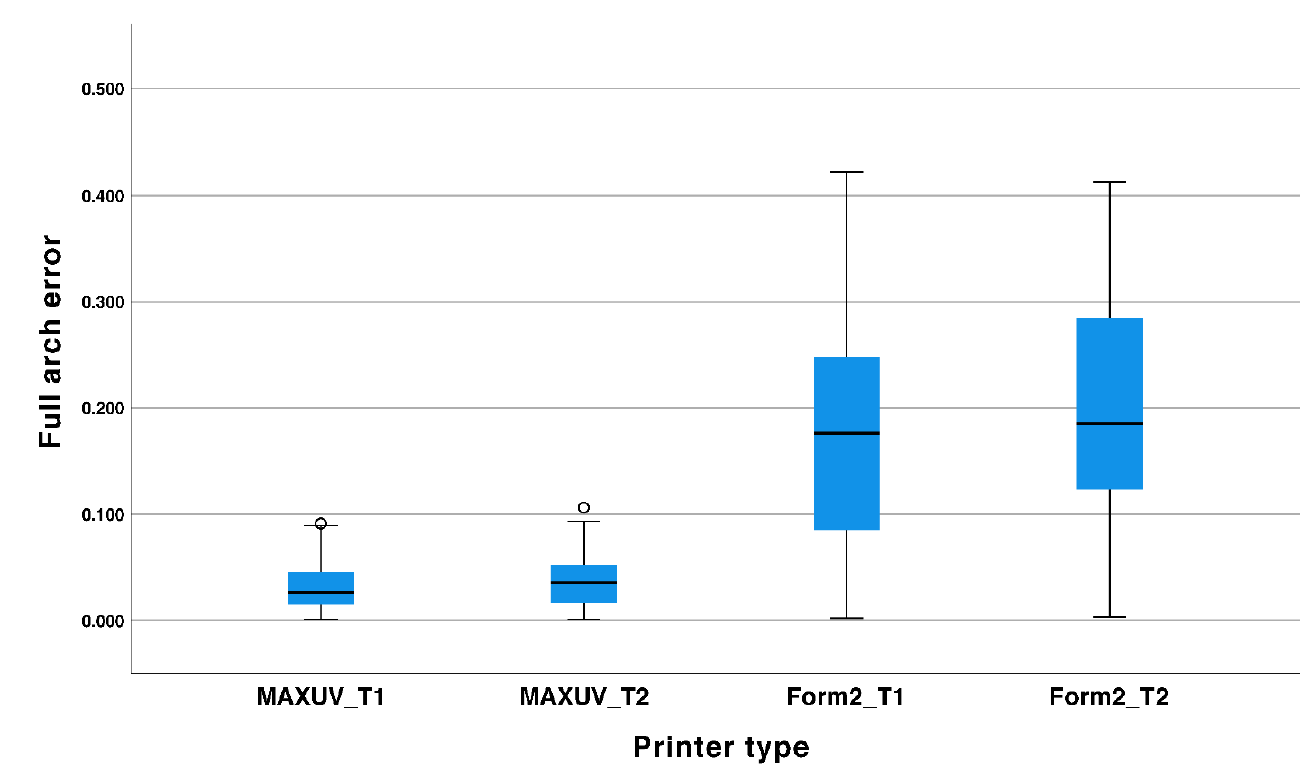
Figure 3. Boxplot for the median error and precision of the full-arch parameter at T 1 (two weeks post-printing) and T 2 (six weeks post-printing) for MAX UV and Form 2 3D printed models. o Denotes outliers more than 1.5 IQR but less than three IQR from the end of the boxplot.